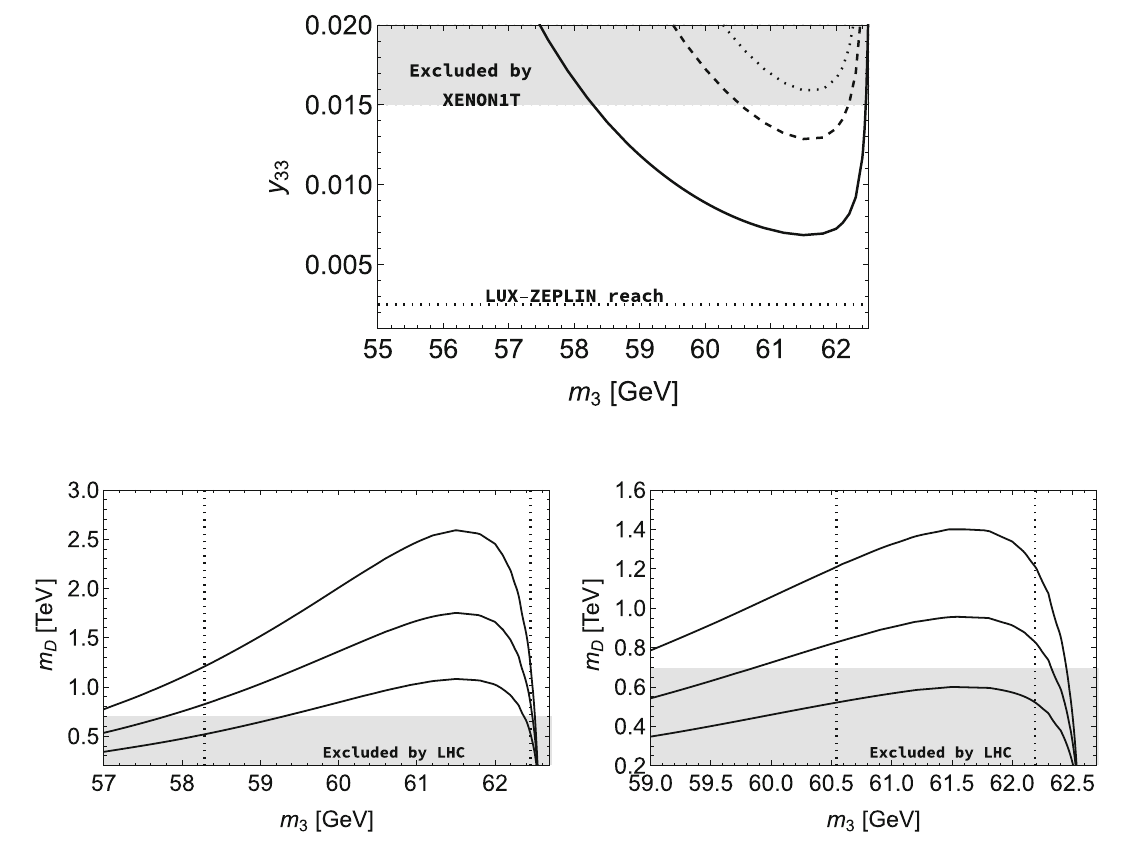
Fig. 4 For DM to be mostly the SO ( 10 ) singlet fermion, in the top-left panel we plot the effective DM Higgs portal coupling y 33 as a function of its mass m 3 . The solid, dashed, and dotted lines are contours along which the DM accounts for 100% , 30%, and 20% of the observed DM abundance (cid:12) DM h 2 = 0 . 12 [9], respectively. The gray shaded region is excluded by the XENON1T results and the search reach of the future LUX-ZEPLIN experiment is depicted by the horizontal dashed line. Both y 33 and m 3 are determined as a function of free parameters m 0 , β